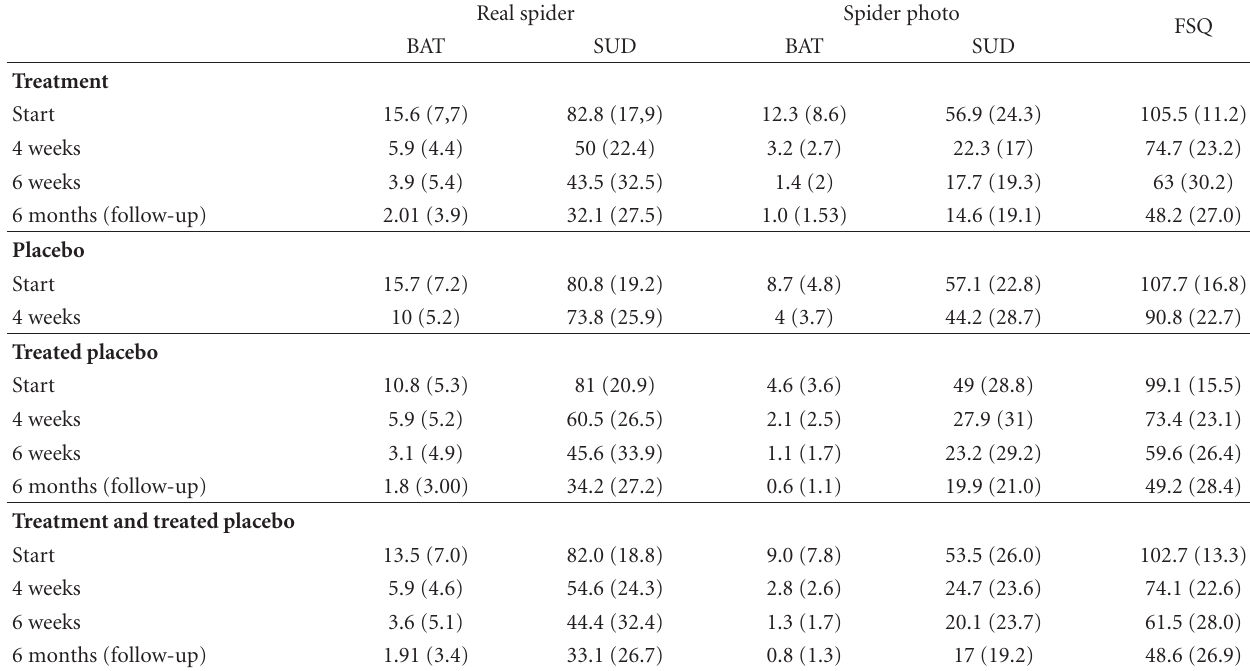
Table 1: Means and standard deviations (in parenthesis) of the BAT, SUDS, and FSQ scores. Treatment ( n = 13) and placebo ( n = 12) group scores were gathered and compared at the end of the 4th week. Treatment group continued treatment until the 6th week. After 4 weeks, ten placebo subjects also underwent treatment, and their improvement was calculated at the 4th and 6th weeks of treatment. Six months later, a follow-up study was